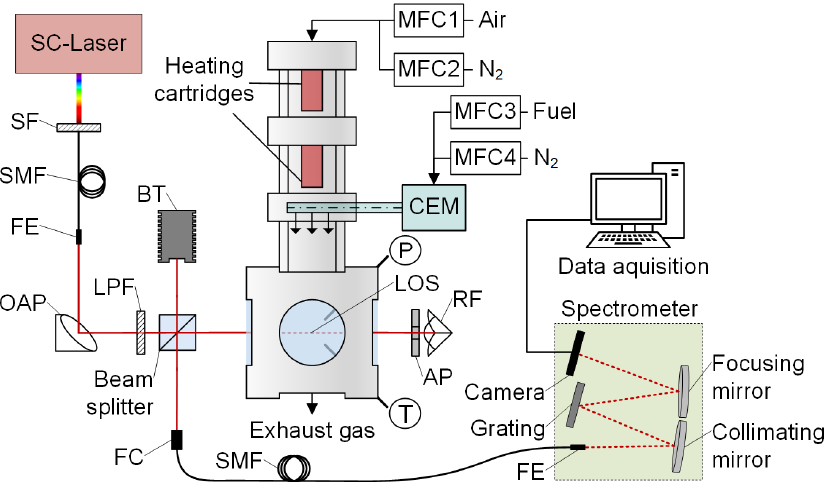
Figure 1. HTC 2 calibration flow cell and the optical supercontinuum laser absorption spectroscopy (SCLAS) configuration. Optical components: spectral filter (SF), single mode fiber (SMF), fiber end (FE), off-axis parabolic mirror (OAP), longpass filter (LPF), beam trap (BT), aperture (AP), retroreflector (RF), and fiber collimator (FC).